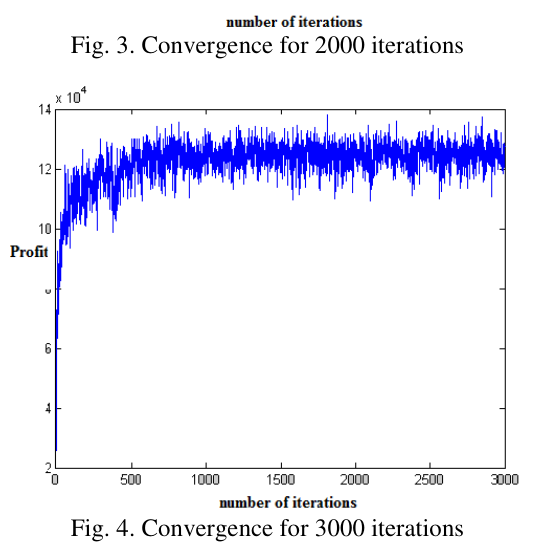
Fig. 3. Convergence for 2000 iterations